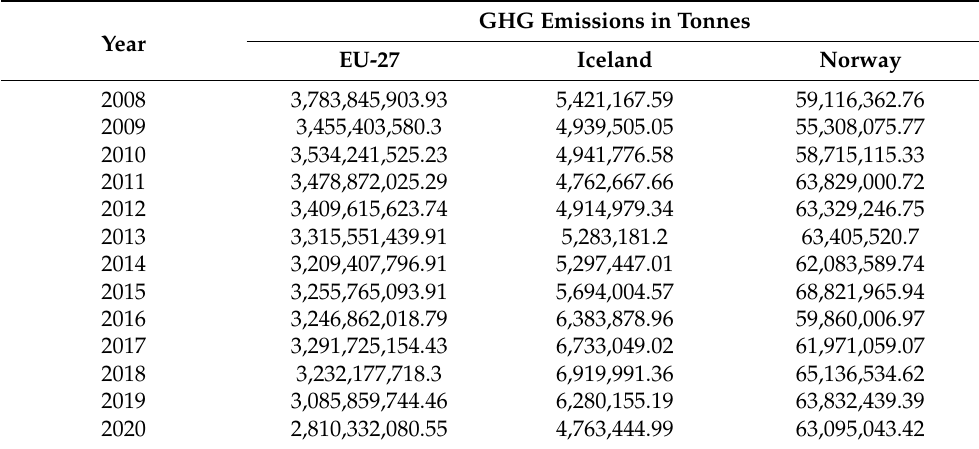
Table A2. Annual calculations of GHG for a prolonged period, accounting for Eurostat data